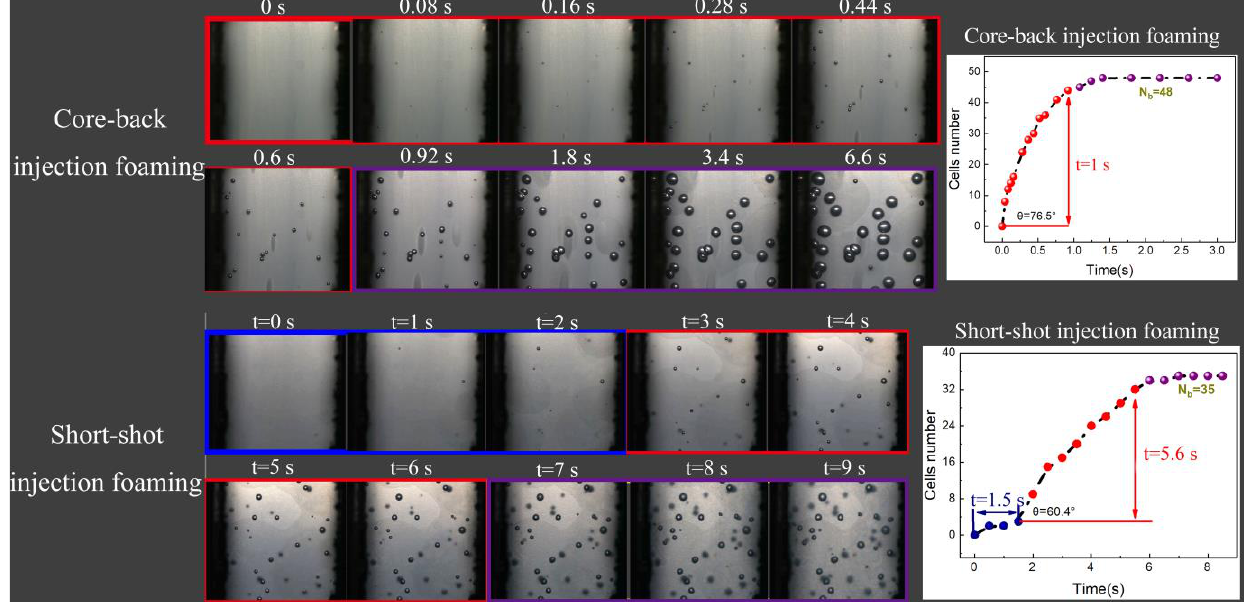
Figure 13. Change in cell number with time in the core-back injection process and the short-shot injection process.